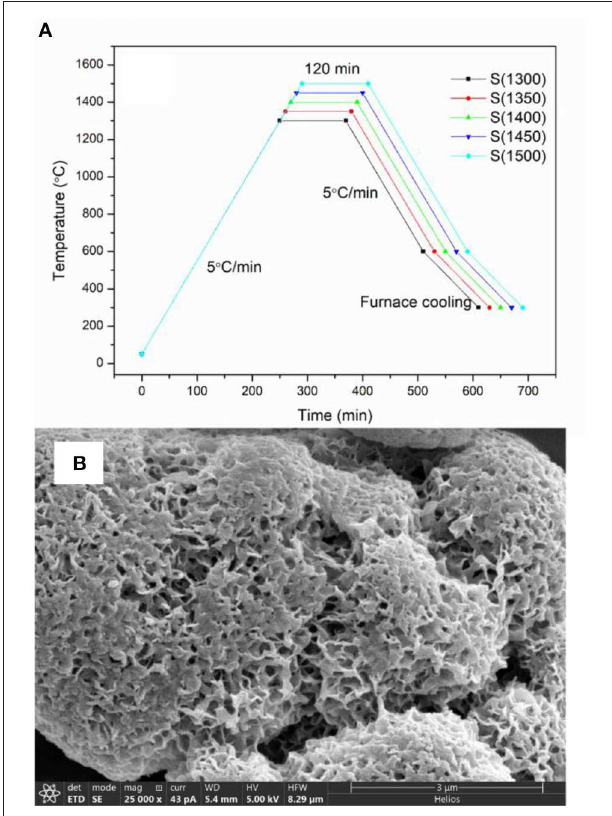
FIGURE 1 | (A) The thermal treatment profile of γ -Al 2 O 3 ; (B) SEM images of γ -Al 2 O 3 .